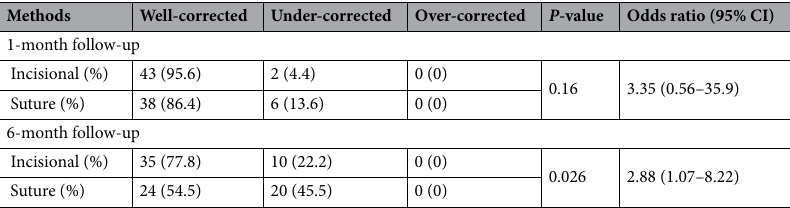
Table 2. Surgical outcome at 1-month and 6-month follow-up after epiblepharon surgery.